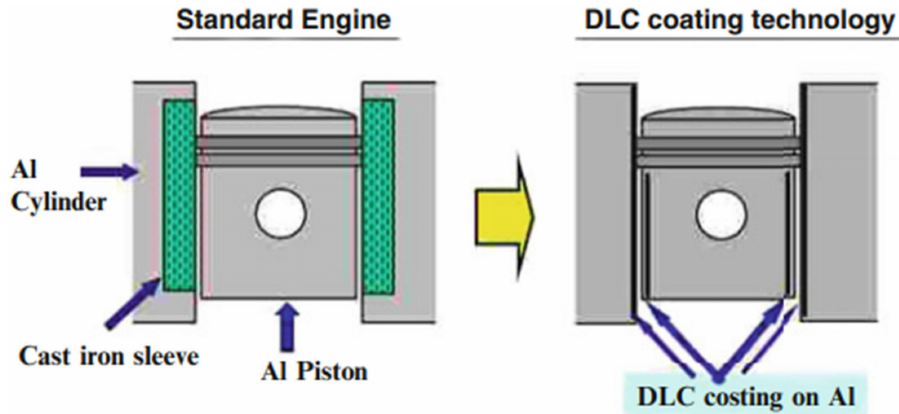
Figure 6. DLC-coated aluminum alloy piston and cylinder for an ultralow-friction engine